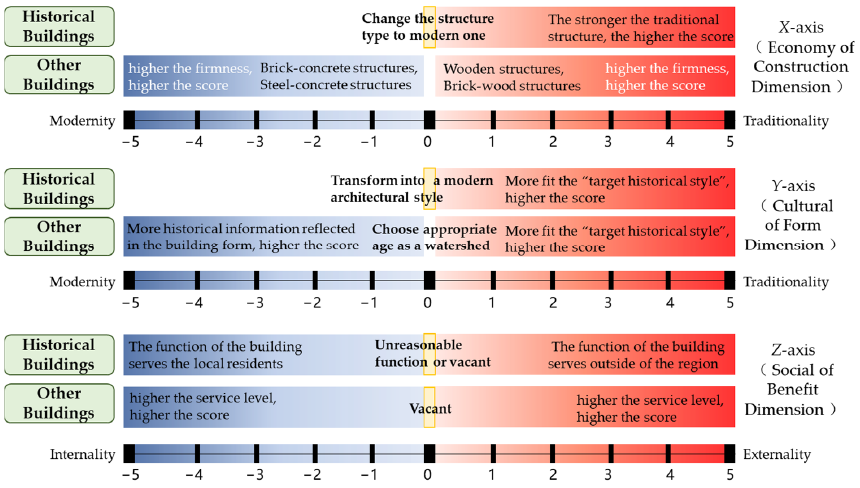
Figure 5. Building classification guide diagram.